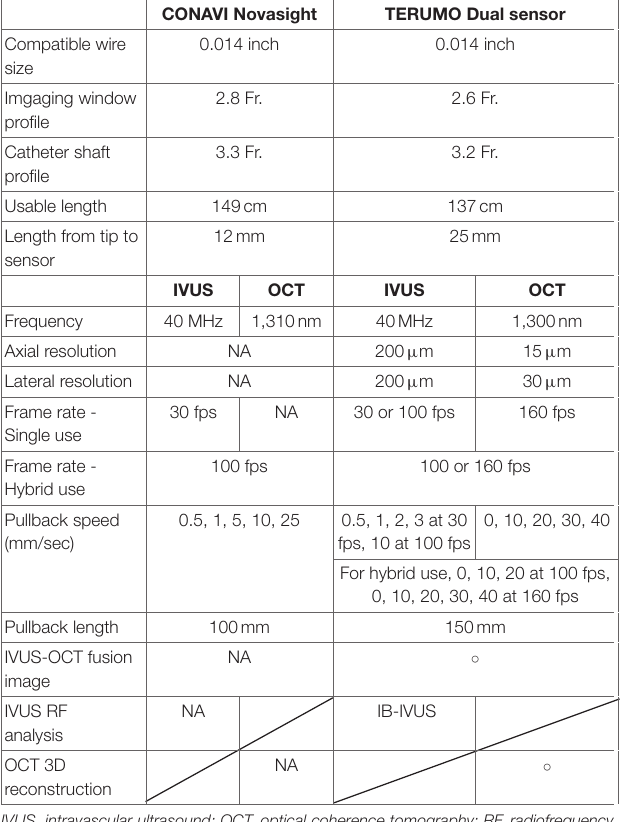
TABLE 1 | The specifications of CONAVI Novasight Hybrid and TERUMO Dual Sensor